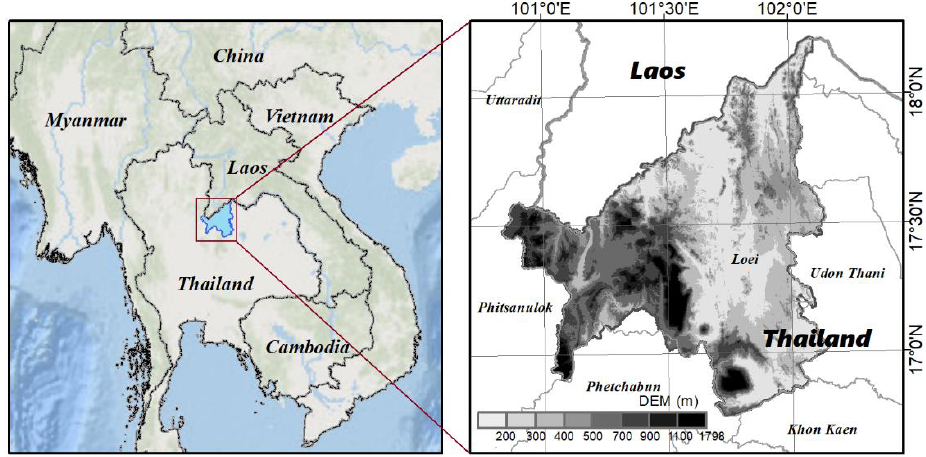
Figure 1. The location and spatial distribution of digital elevation model (DEM) of Loei Province,